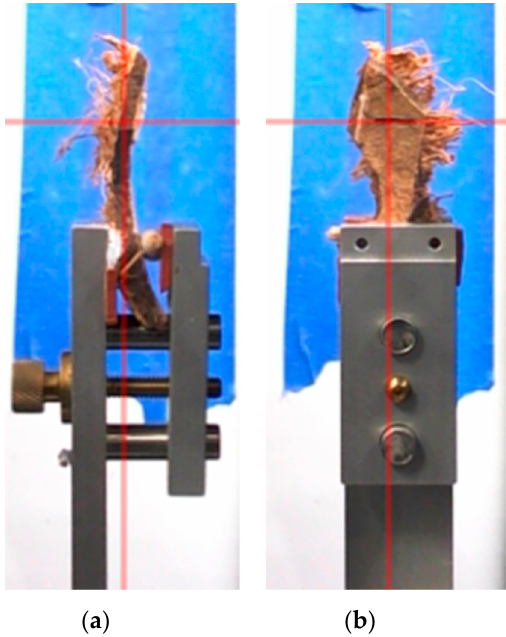
Figure 3. An X-ray computed tomography (CT) fixture and a coconut specimen at two orientations. ( a ) side view; ( b ) front view.